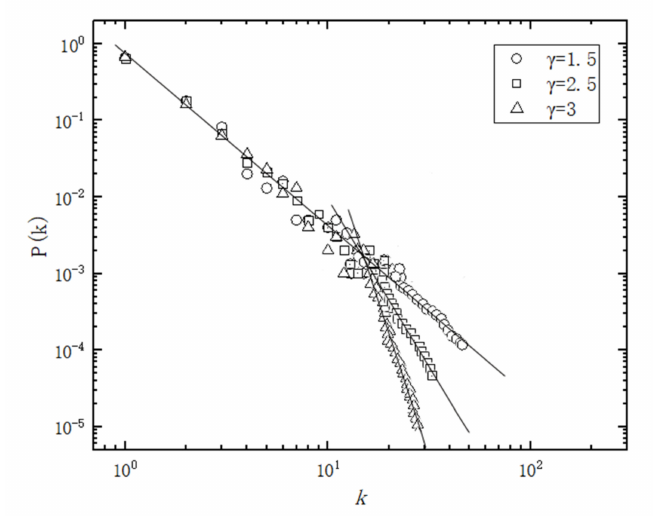
Figure 6. Network node degree distribution of the numerical experiment and model simulation under different